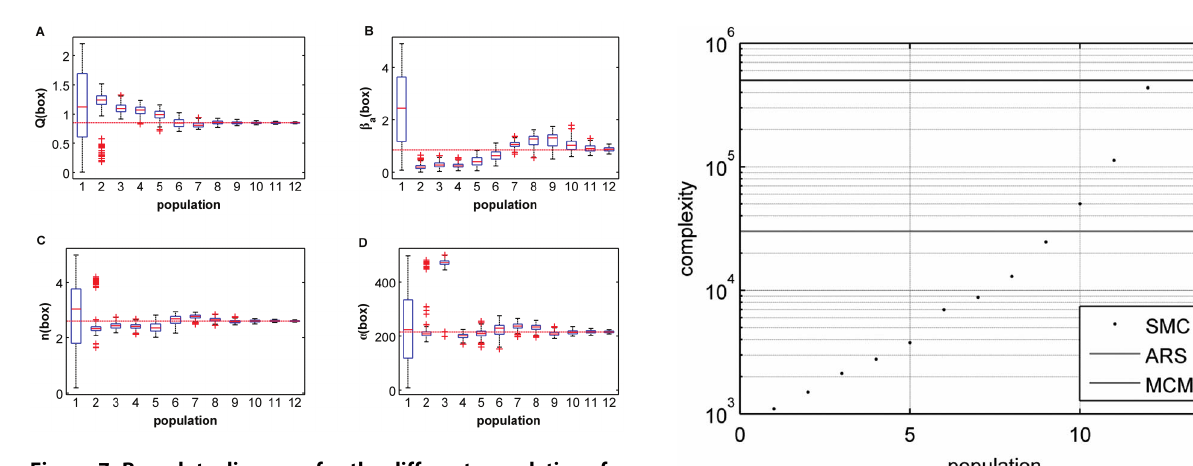
Figure 7. Box plots diagrams for the different populations for each parameter. (A) Q, (B) b a , (C ) n and (D) a .